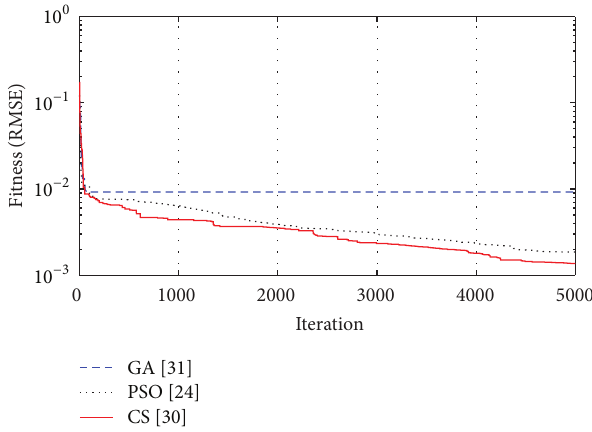
Figure 2: Convergence process of different optimization algorithms during the parameter estimation process of the SDM.